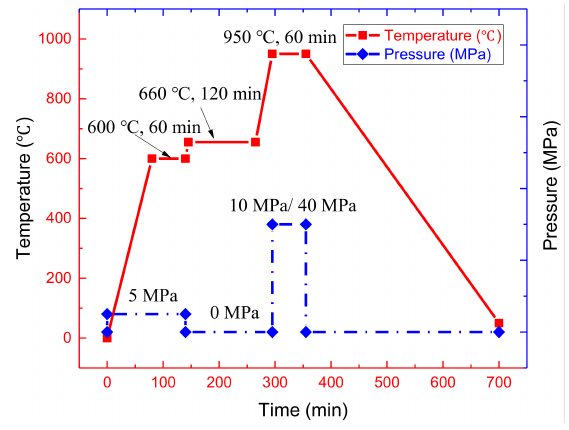
Figure 4. Schematic illustration of the sintering